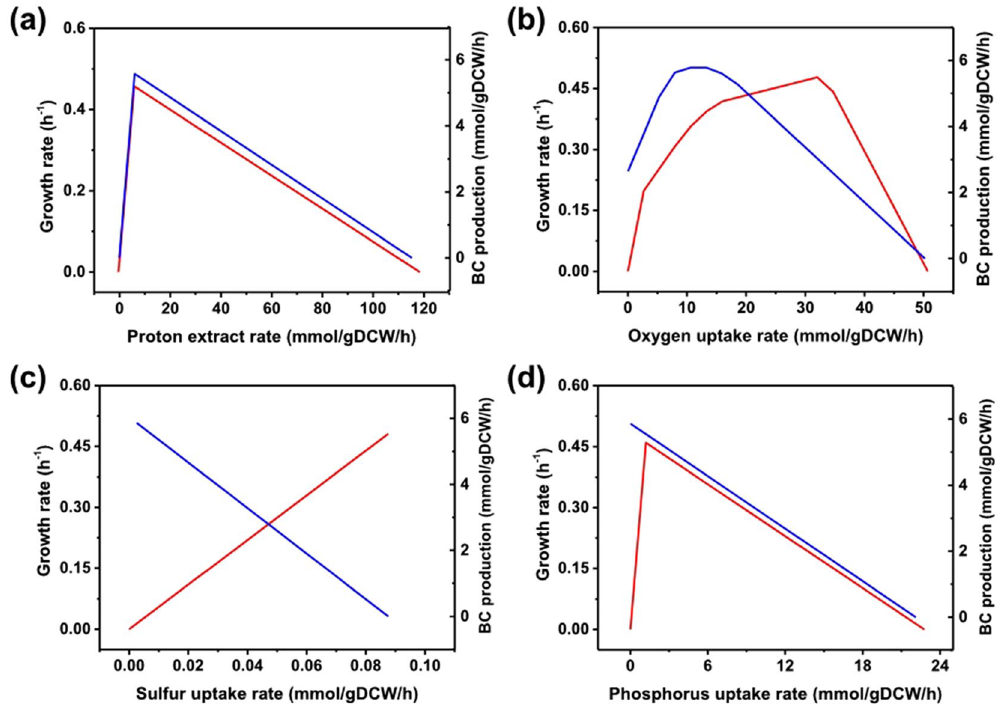
Figure 6. Simulation of the effects of perturbation of culture conditions on BC production and cell growth. Robustness analysis of the proton extraction rate (a) , oxygen uptake rate (b) , sulphur uptake rate (c) , and phosphorus uptake rate (d) . The red line indicates the cell growth rate, and the blue line denotes the BC production